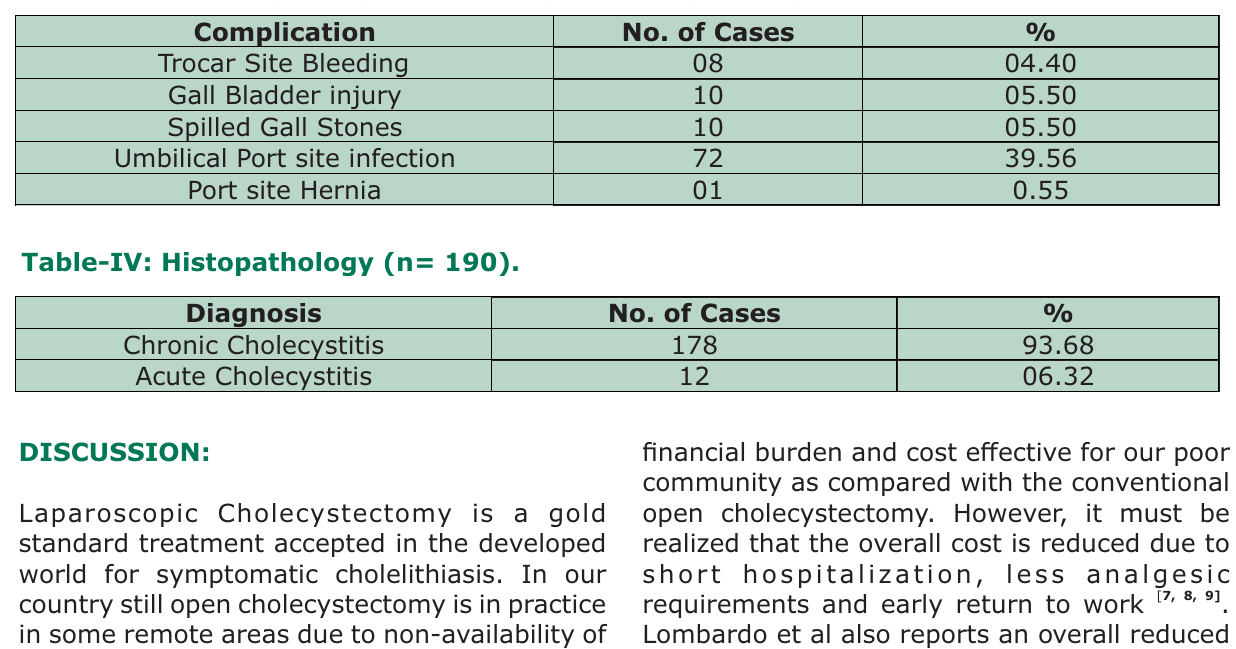
Table-III: Intra/ post-operative complications (n=182).